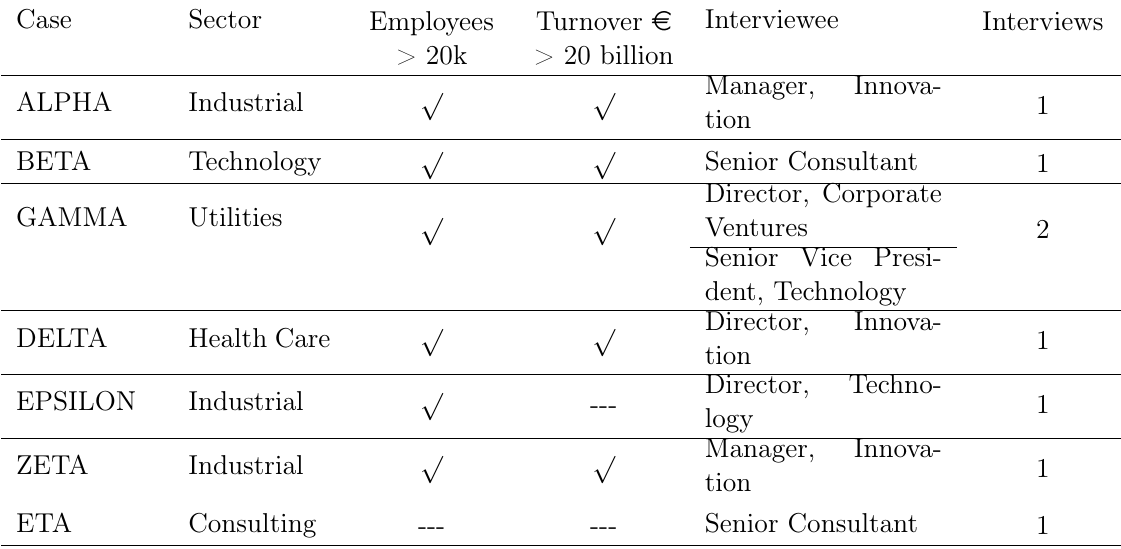
Table 1. Profiles of the